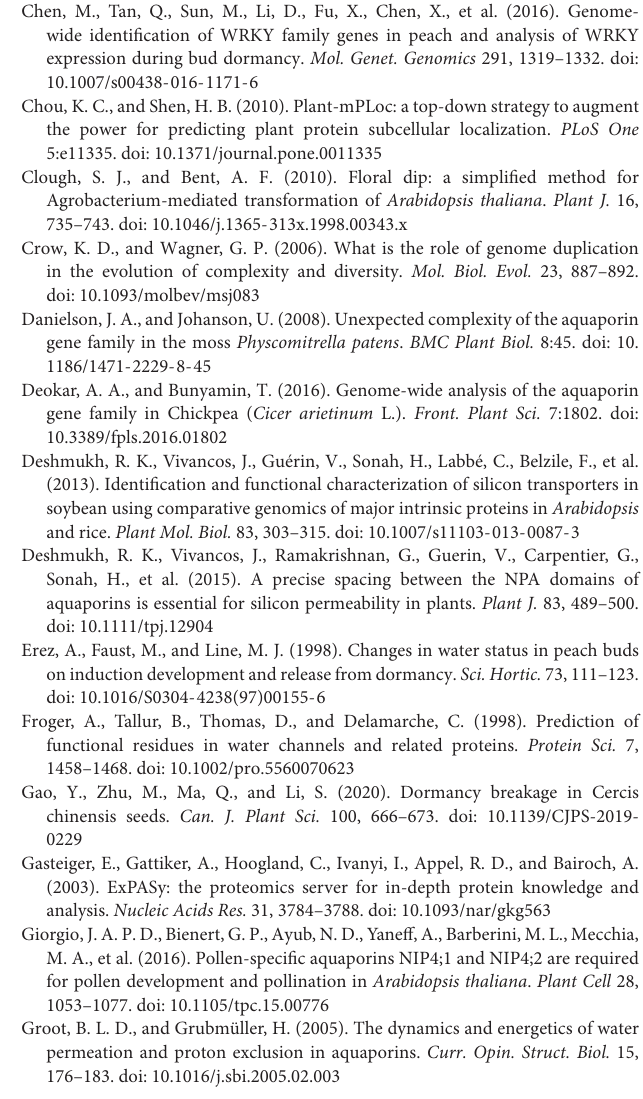
Supplementary Figure 9 | qRT-PCR analysis of the relative expression of 20 genes during the dormancy and sprouting stages of P. armeniaca . Supplementary Table 1 | Complete coding sequences and corresponding amino acid sequences of the AQP genes of P. armeniaca .